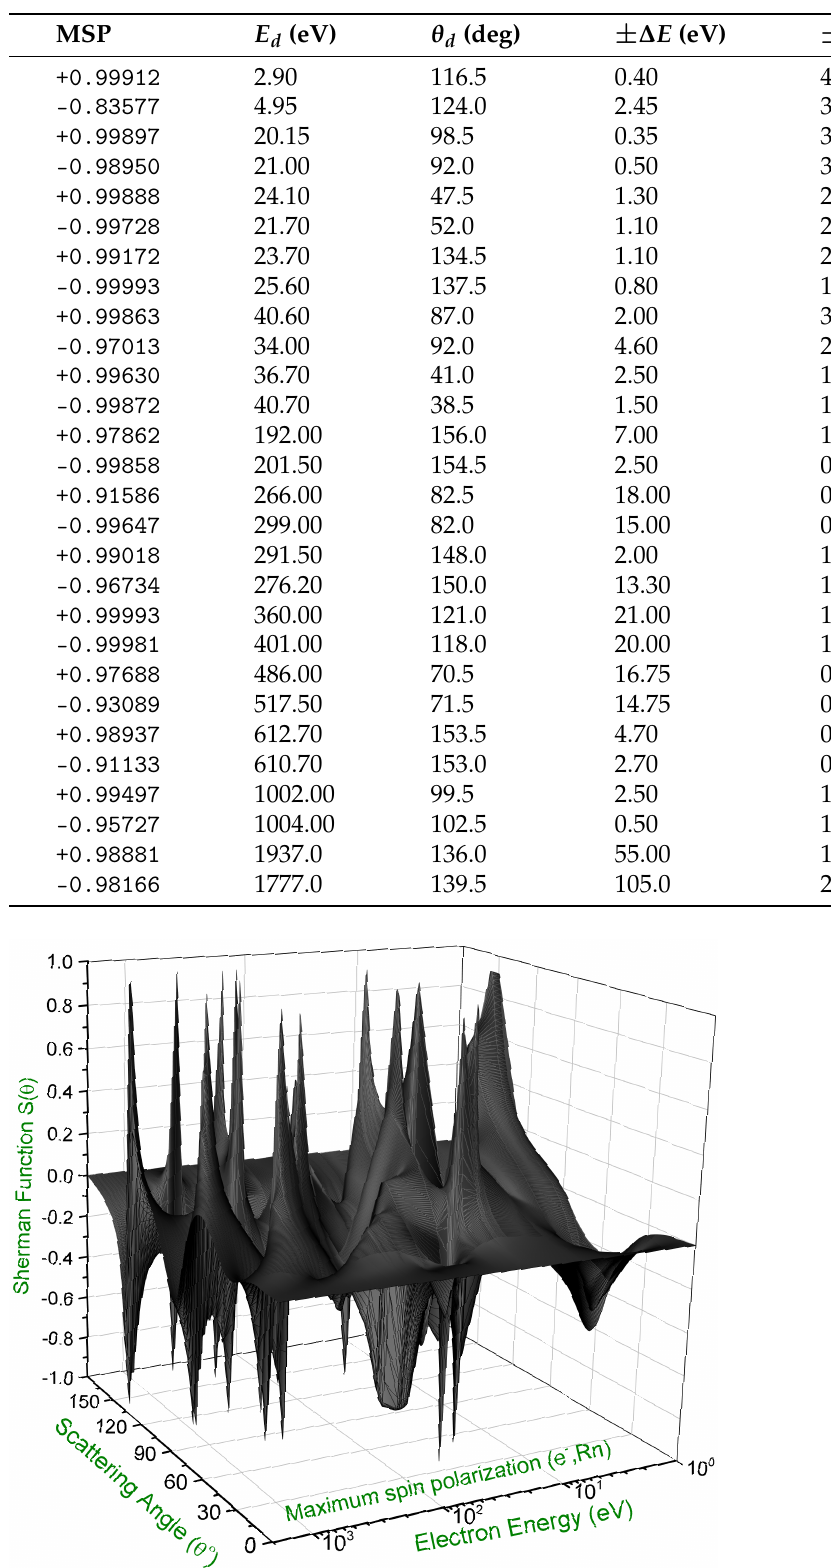
Table 2. Maximum spin polarization (MSP) with their positions ( E d , θ d ) and deviations in energy ∆ E and angle ∆ θ from the respective CM positions for e − - 222 Rn elastic scattering.